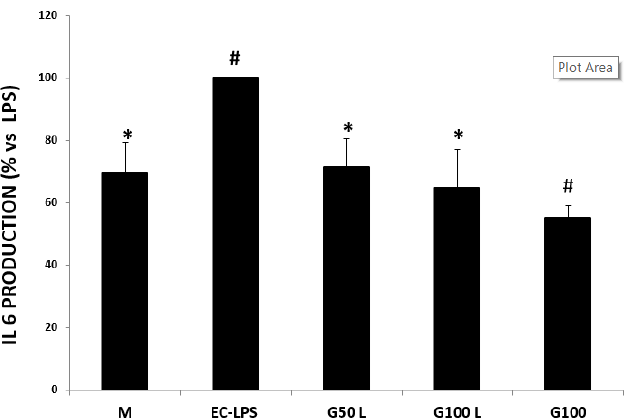
Figure 5. GAAE pre-treatment effect on IL-6 production in normal controls challenged with EC- LPS . Biopsies were treated only with medium culture (M), or with 1 mg/mL of EC-LPS or pretreated for 3 h with 50 and 100 µg/mL GAAE, then challenged for 18 h with EC-LPS (G50 L and G100 L) or treated only with 100 µg/mL GAAE (G100). Results are expressed as a percentage of each treatment with respect to EC-LPS ± S.E.M. ( N = 15), * p < 0.05 vs. EC-LPS, # p < 0.05 vs. medium (Student’s t -test).